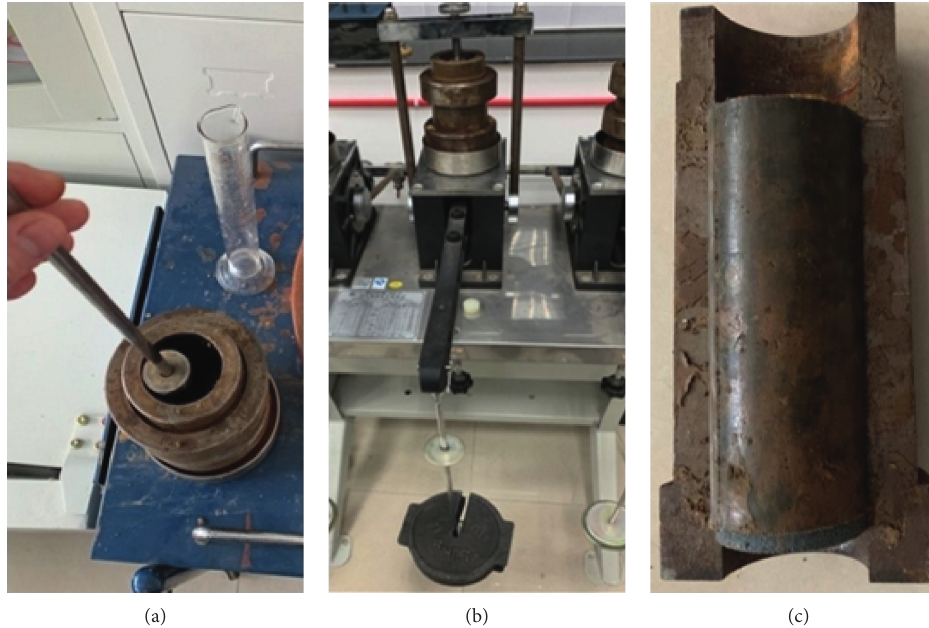
Figure 5: Sample preparation process with consolidometer. (a) Filling. (b) Compacting. (c) Removing the sample.